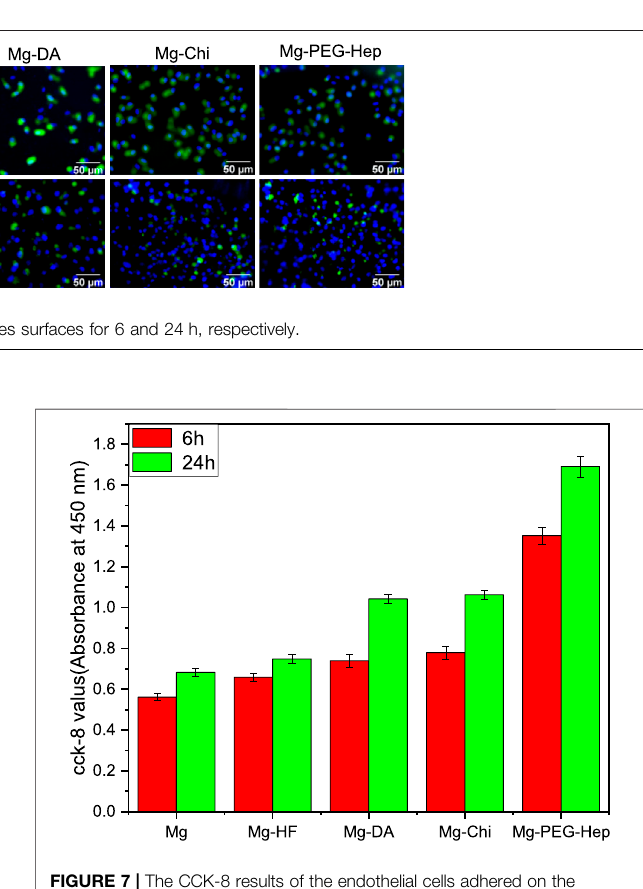
FIGURE 7 | The CCK-8 results of the endothelial cells adhered on the different samples for 6 and 24